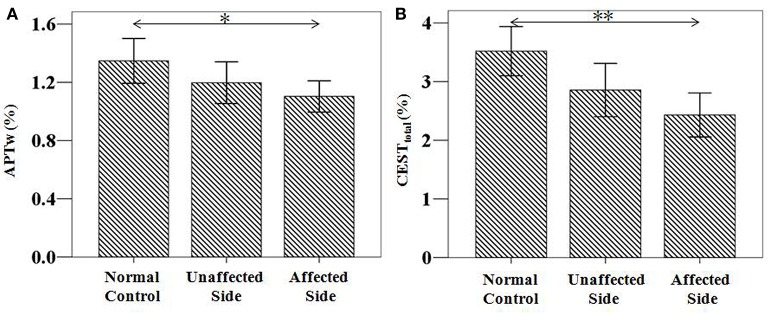
APTw and CESTtotal values of the substantia nigra for patients with unilateral symptoms (n = 21). Both showed a significant decrease in the affected side [APTw: (1.10 ± 0.11)%; P = 0.027; CESTtotal: (2.43 ± 0.38)%; P = 0.001], compared to normal controls [APTw: (1.35 ± 0.15)%; CESTtotal: (3.52 ± 0.42)%]. *P < 0.05; **P < 0.01.